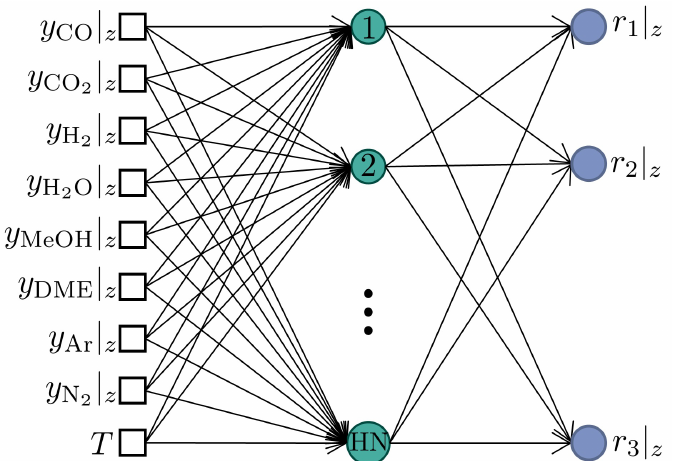
Figure 5. Schematic representation of ANN’s architecture for the hybrid model